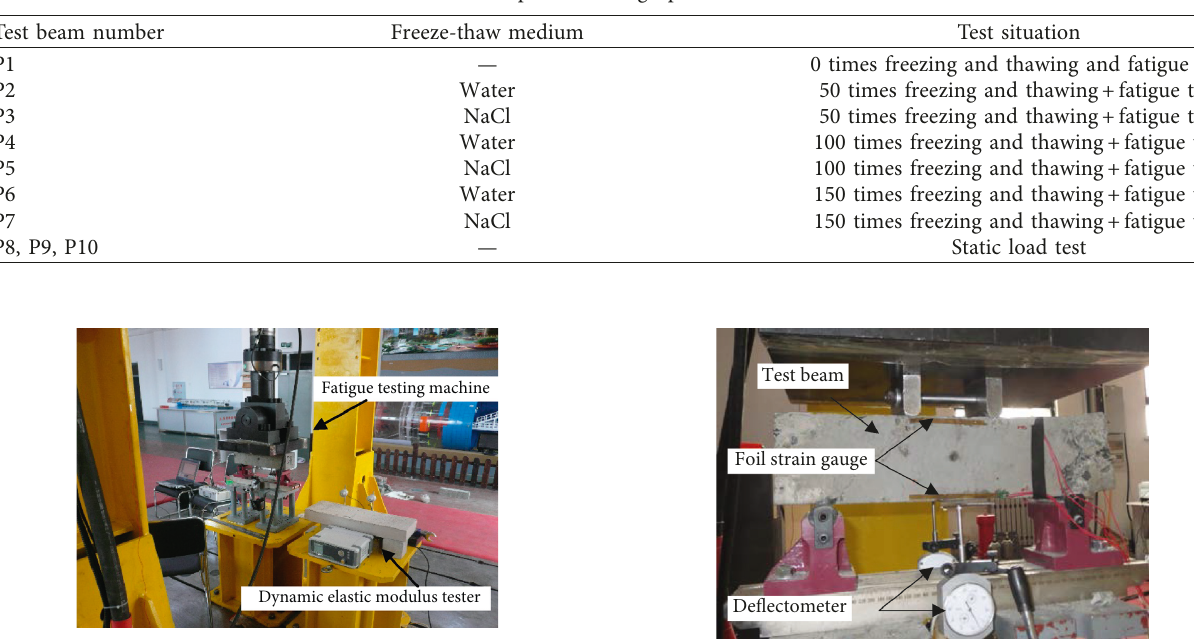
Figure 1: Reinforced concrete specimen reinforcement plan (unit: mm). Table 3: Specimen design parameter list.